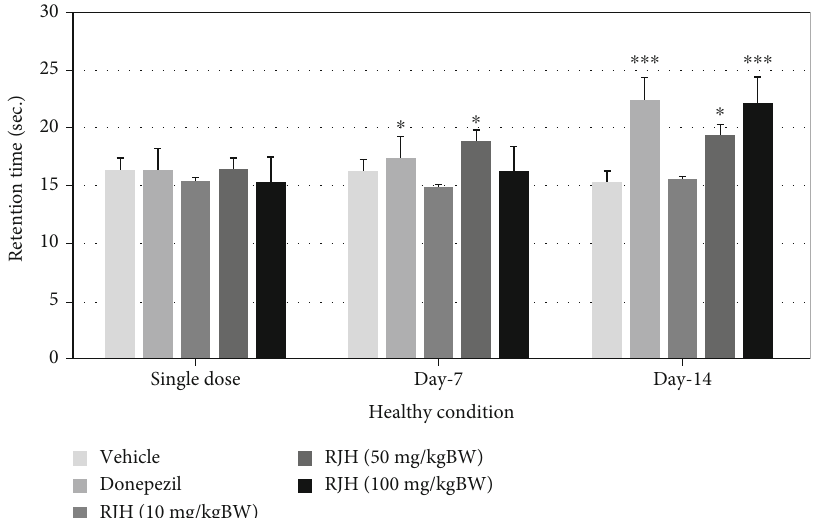
Figure 4: The e ff ect of RJH on retention time in healthy condition. Rats were treated with vehicle, donepezil, or RJH in various doses ranging from 10, 50, to 100mg/kg BW. Data are presented as mean ± SEM ( n = 8/group ). ∗ p < 0 : 05 compared with the vehicle-treated group; ∗ p < 0 : 05 and ∗∗∗ p < 0 : 001 compared with the vehicle-treated